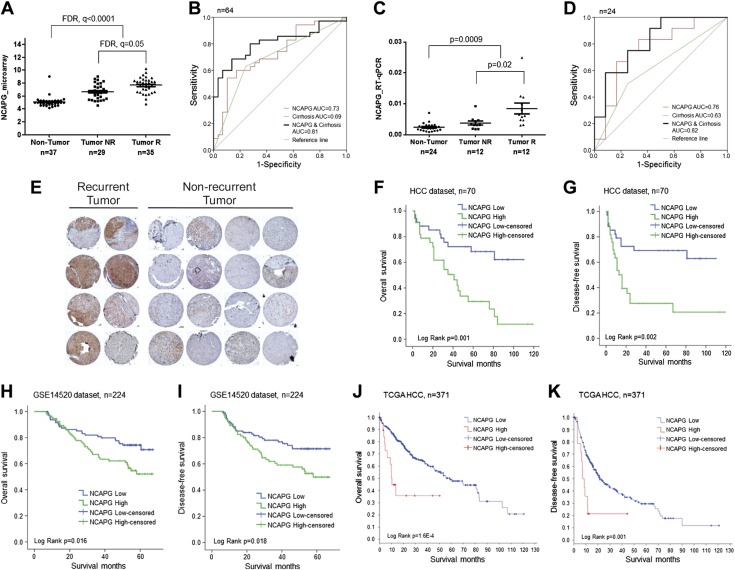
NCAPG is significantly associated with tumor recurrence postresection and poorer patient survival. A) NCAPG is significantly up-regulated in early recurrent tumors compared with nonrecurrent tumors in our HCC microarray dataset. B) ROC curve analysis shows NCAPG, cirrhosis, or NCAPG and cirrhosis in combination in discriminating recurrent and nonrecurrent HCC tumors in these 64 patients. C) NCAPG is validated using qRT-PCR to be significantly overexpressed in 12 independent early recurrent tumors compared with 12 independent nonrecurrent tumors. D) ROC curve analysis shows NCAPG, cirrhosis, or NCAPG and cirrhosis in combination in discriminating recurrent and nonrecurrent HCC tumors in these 24 independent samples. E) Immunohistochemistry staining showed significantly higher NCAPG levels in recurrent tumors compared with nonrecurrent tumors. F–K) High NCAPG level is significantly associated with poorer overall survival in the HCC dataset (F), GSE14520 dataset (H), and TCGA HCC dataset (J). High NCAPG level is significantly associated with poorer disease-free survival in the HCC dataset (G), GSE14520 dataset (I), and TCGA HCC dataset (K). NR, nonrecurrent; R, recurrent.